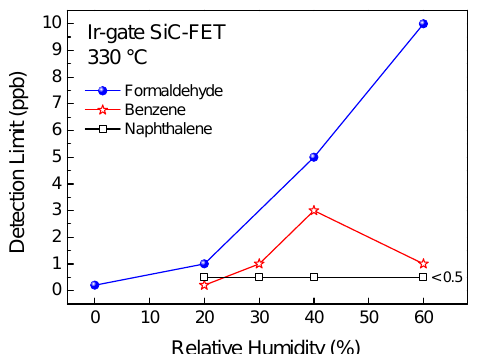
Figure 10. Sensor response to very low concentrations of benzene (C 6 H 6 ) from 3 to 0.2ppb at 330 ◦ C and 20%RH. The sensor signal is not filtered.